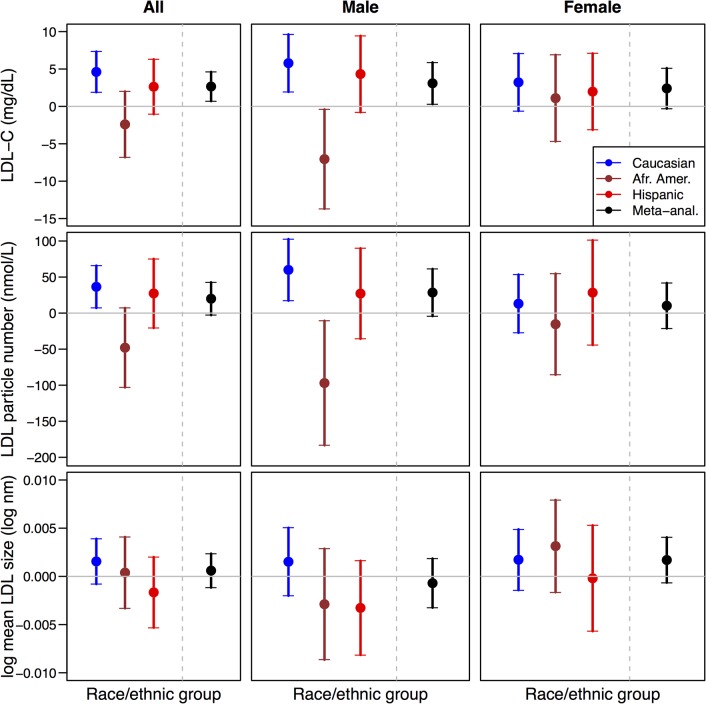
Summary of estimated genetic additive effects of rs4238001 allele T on LDL-C (mg/dL), LDL particle number (nmol/L) and LDL particle size (log nm) under a basic regression model (Model 1).Analyses were conducted stratified by race/ethnic group and combined by meta-analysis, for all participants as well as stratified by sex (males or female).